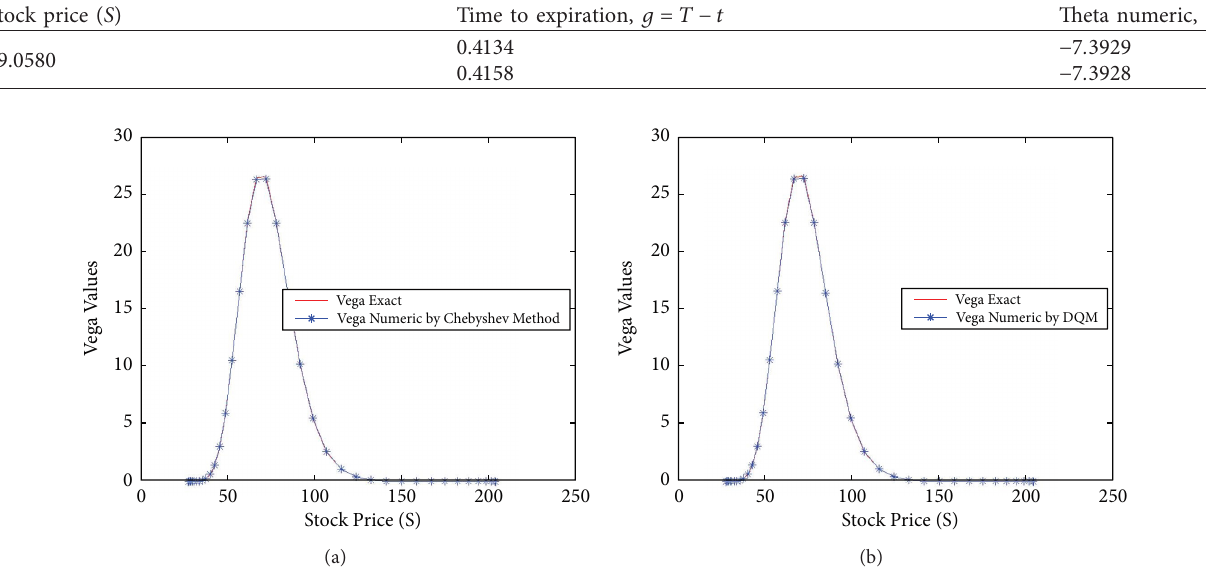
Table 5: Theta values for different time to